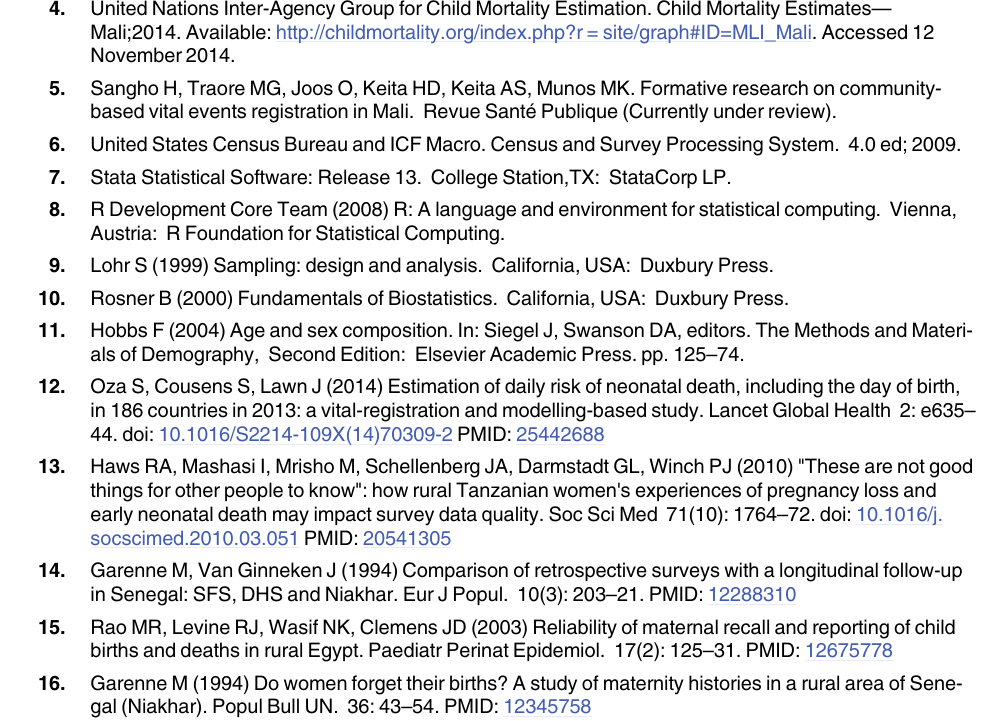
PLOS ONE | DOI:10.1371/journal.pone.0132164 November 25,